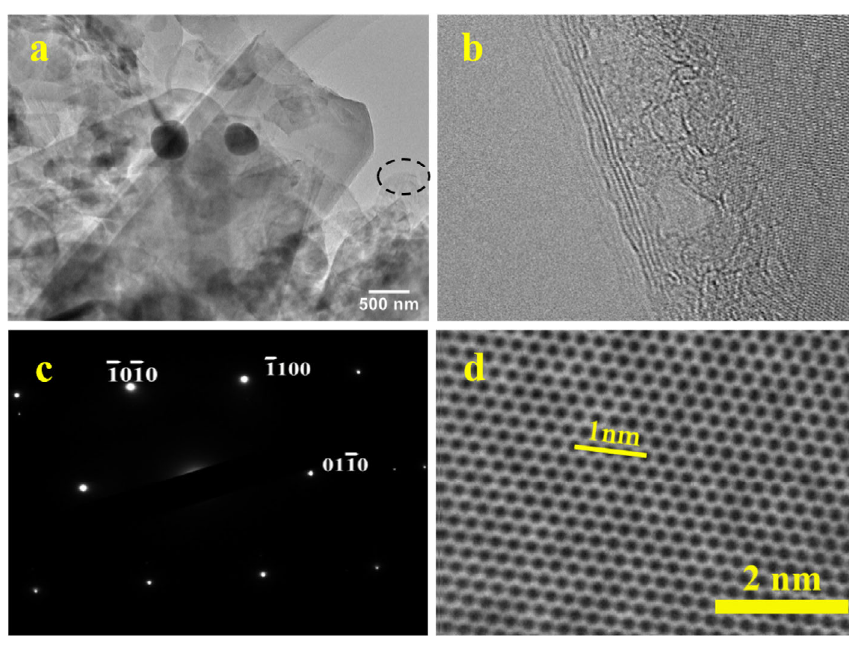
Fig. 3 (a) Low-magnification TEM image of BNNS. (b) High-resolution image of the encircled region in (a); (c) SAED of the region in (a); (d) HRTEM and structure model of BNNS.